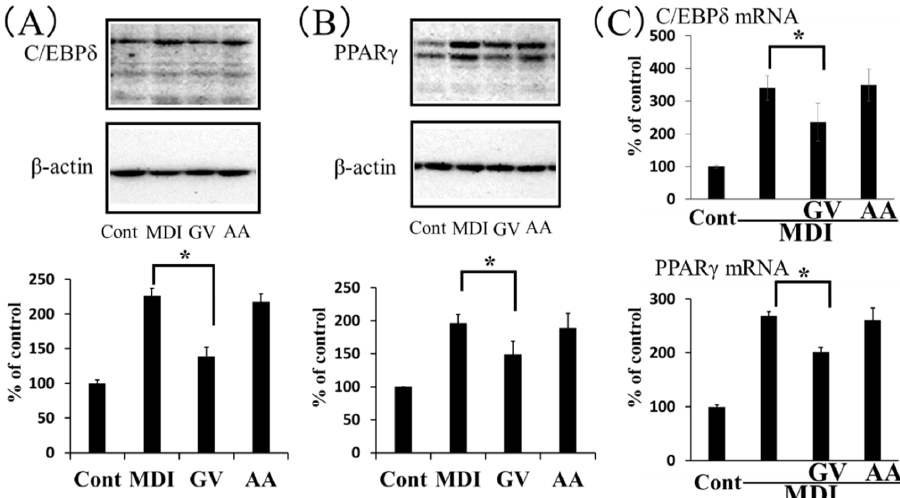
Figure 3. Effects of ginkgo vinegar and acetic acid on the expression of key proteins involved in adipocyte differentiation. Confluent 3T3-L1 cells were induced to differentiate into adipocytes in the presence of 0.4% ginkgo vinegar (GV) or 0.02% acetic acid (AA) for 2 days. (A, B, upper panels) Representative Western blot images show cellular protein levels of ( A ) C/EBPδ and ( B ) PPARγ (lower panels). Results from ImageQuant TL quantifications of band intensities show protein expression levels relative to β-actin expression. ( C ) Real-time PCR results show C/EBPδ and PPARγ gene expressions in 3T3-L1 cells induced to differentiate into adipocytes in the presence of 0.4% ginkgo vinegar or 0.02% acetic acid. Data represent the mean ± SD ( n = 3). * p < 0.05.